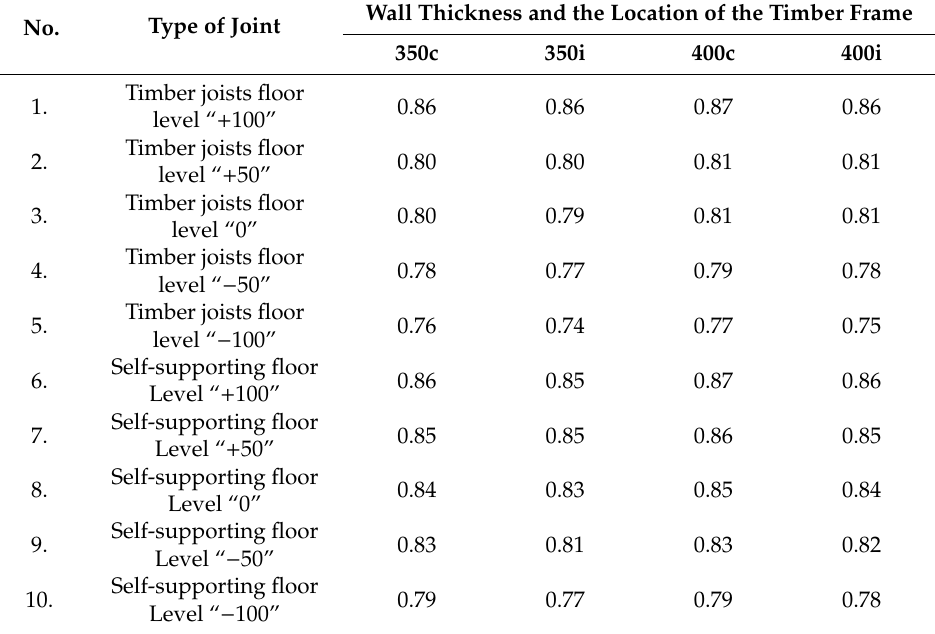
Table 5. Temperature factors f 0.25 [ ◦